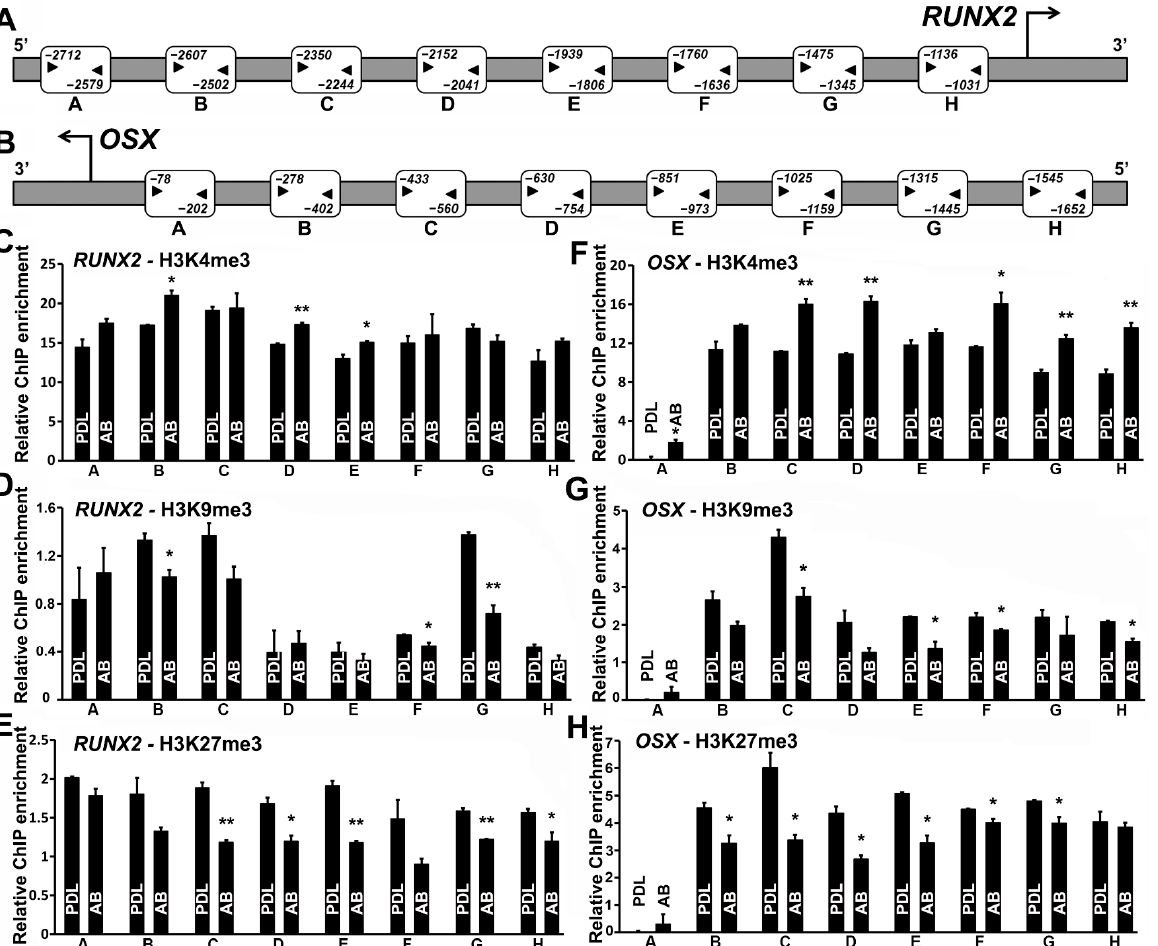
Figure 2. RUNX2 and OSX promoters are characterized by repressive histone modifications in PDL progenitors. Human RUNX2 promoter ( A ) and OSX promoter ( B ). Region upstream to the transcription start site (TSS) was probed for histone H3K4me3, H3K9me3, and H3K27me3 enrichment with 8 primer pairs, as indicated. Primer binding sites are indicated alongside the regions amplified for both RUNX2 and OSX promoters. ChIP-qPCR-based histone H3K4me3 ( C , F ), H3K9me3 ( D , G ), and H3K27me3 ( E , H ) enrichment at the regions indicated on RUNX2 and OSX promoters, respectively. Note the higher levels of repressive histone modifications (H3K9me3 and H3K27me3) on RUNX2 and OSX promoters in PDL when compared with AB cells. The active histone modification H3K4me3 was preferentially enriched on RUNX2 and OSX promoters in AB cells when compared with PDL cells ( C , F ). ChIP analyses were independently performed with each primer pair, and representative enrichment plots are shown (n = 4–5). Enrichment values are graphed as mean ± SD (* p < 0.05, ** p < 0.01).